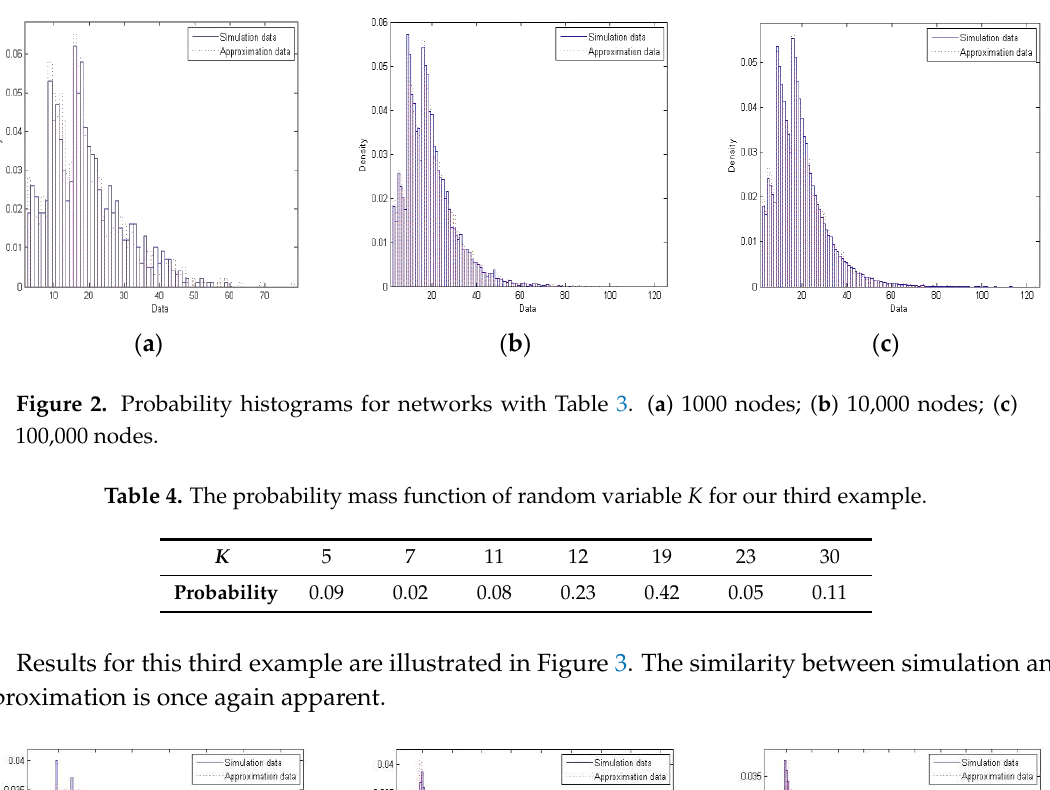
( c ) Figure 1. Probability histograms for networks with Table 2. ( a ) 100 nodes; ( b ) 1000 nodes; ( c ) 10,000 nodes. We next move on to the second example. Table 3 contains the possible options for initial degree that a node of the considered network may be given. A quick arithmetic returns  0 = 9.55; such is employed to establish the desirable mixture 𝒦 . Table 3. The probability mass function of random variable K for our second example. K